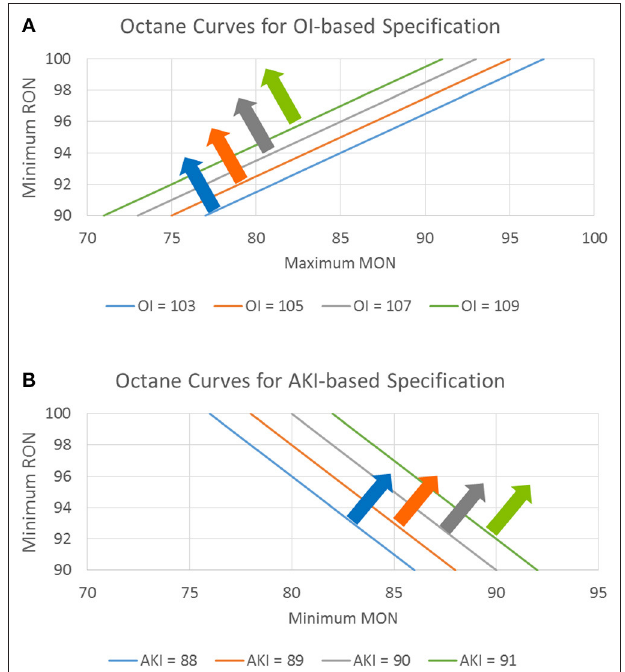
FIGURE 14 | The octane curves define the RON and MON required to meet different gasoline antiknock qualities under (A) OI-based and, (B) AKI-based specification methods. An AKI standard pushes gasoline antiknock quality into a different direction compared to engine